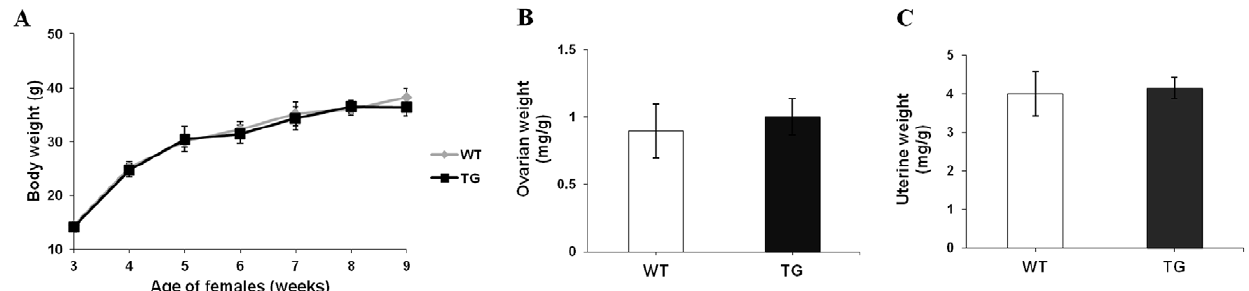
Figure 4. Effects of pFSH a and pFSH b expression on body and reproductive organ weights. (A) Growth curves for TG and WT females from birth to 9 weeks of age. (B–C) Ovary- and uterus-to-body weight ratios (mg/g) for TG ( n =12) and age-matched WT ( n =11) females (19–21 weeks of age). No effect was detected. The results of the analysis of each of the two separate lines were found to be comparable to that of the combined analysis.